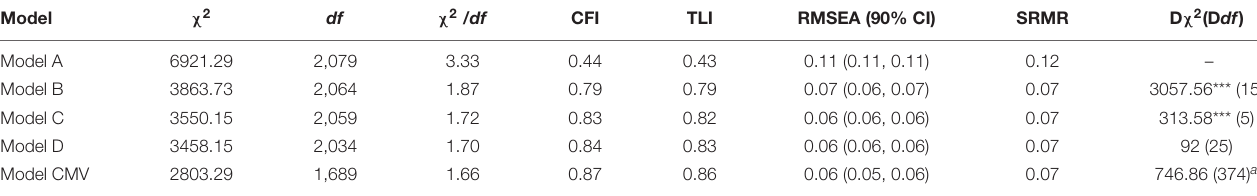
TABLE 1 | Measurement model